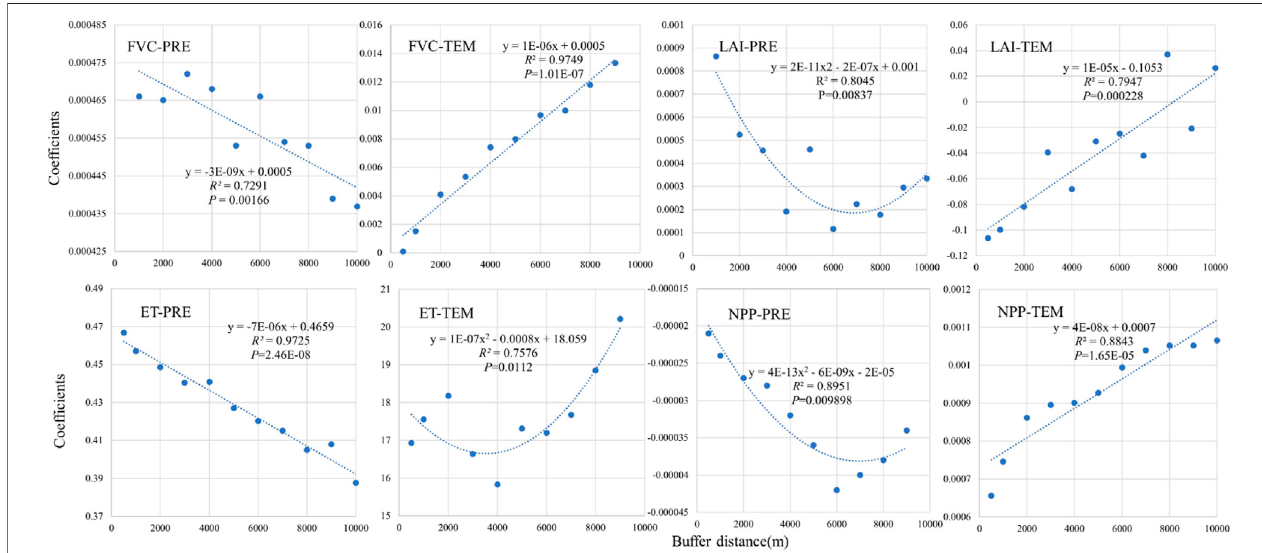
FIGURE 8 | Regression coef fi cients of ecosystem service indicators against climate change in buffer distances. The outliers were removed to derive the better trends.